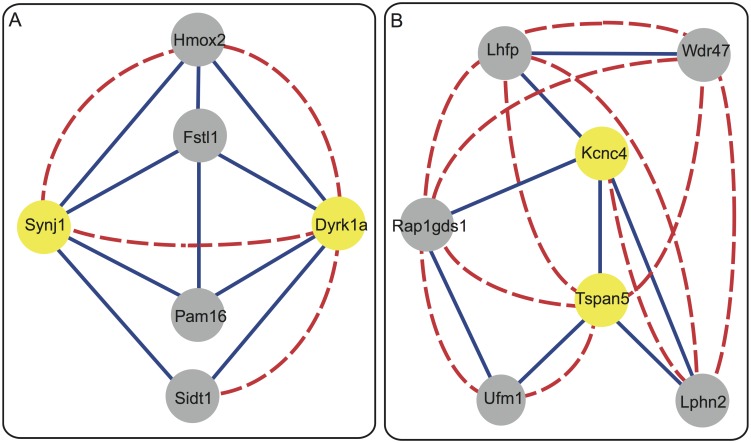
Chromatin interactions of gene-pairs in the CIN at 200kb resolution.(A) Synj1-Dykr1a (yellow nodes) in Chromosome 16 are co-expressed (dashed red link) but their corresponding genomic loci do not interact frequently (no blue link). Both genes have strong chromatin interactions with 4 other genes (grey nodes) resulting a high Jaccard index between them. (B) Kcnc4-Tapan5 (yellow nodes) in Chromosome 3 directly interact (solid blue line) but they are not strongly co-expressed (no dashed red line). This direct chromatin interaction explains the strong co-expression between other gene-pairs in their neighbourhood, such as Wdr47-Tapan5 and Wdr47-Rap1gds1, which are not directly connected in the CIN themselves (no solid blue line). The betweenness centrality measure of the link between Kcnc4-Tapan5 can describe the strong co-expression between their neighbouring genes. Chromatin interaction and co-expression are shown by solid blue and dashed red links, respectively.